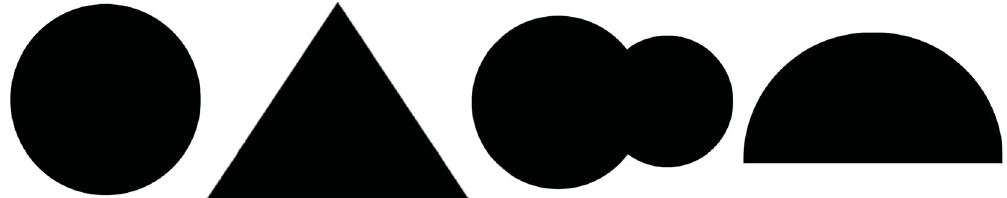
Fig. 7 Display shapes chosen for observation. Left to right: circle , triangle , intersecting circles , and semi-circle